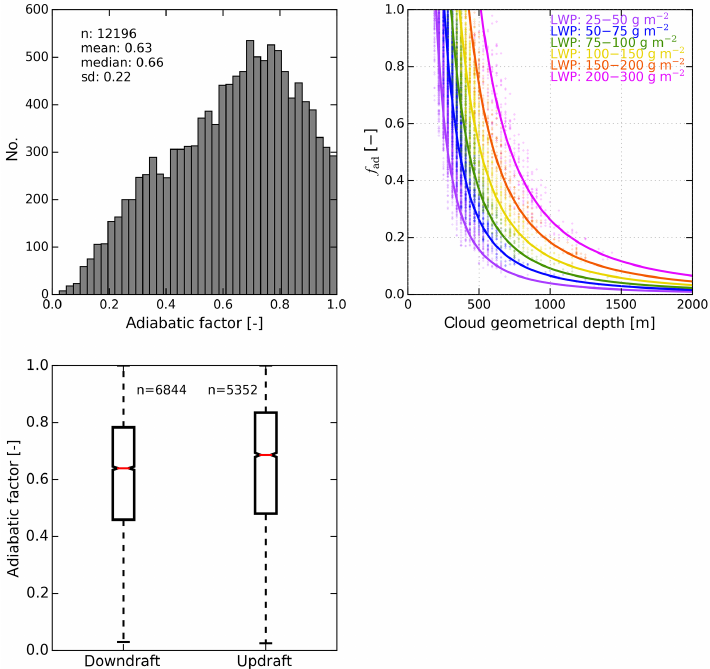
Figure 3. (a) Histogram of f ad in 2012 and 2013 at LACROS. (b) f ad as a function of observed H . Colours indicate different Q L bins. The solid lines represent the relationship described in Eq. (2) for bin mean Q L and (cid:48) ad = 1 . 9 × 10 − 3 gm − 4 . (c) f ad separated by up- and downdraft at the cloud